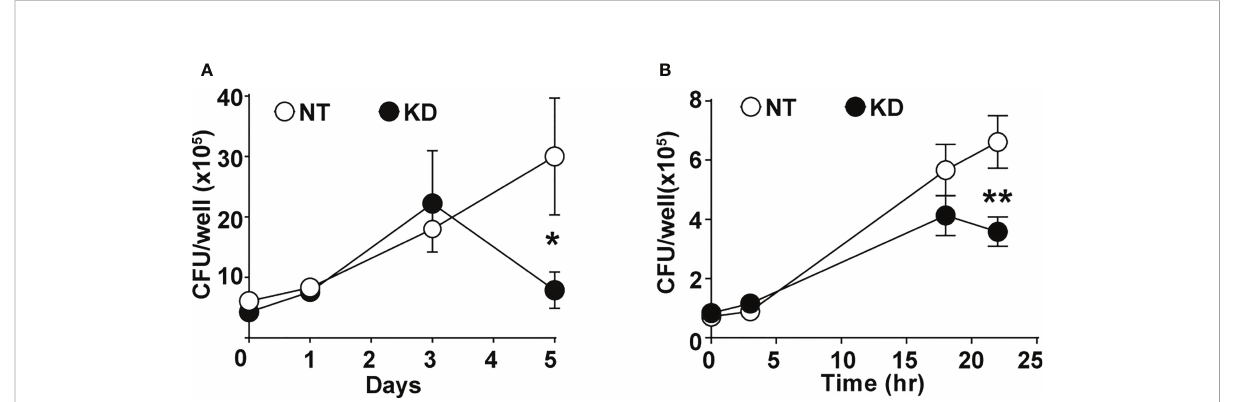
FIGURE 6 CMPK2 regulates the bactericidal activity of macrophages. (A) Growth kinetics of Mtb in NT and KD macrophages at different times post- infection at a MOI of 5 for 6 h Values are mean CFU ± SEM values in triplicate assays of N = 4. (B) Growth kinetics of STM in NT and KD macrophages at different times post-infection at a MOI of 10 for 20 min. Values are mean CFU ± SEM values in triplicate assays of N = 4. Mtb, Mycobacterium tuberculosis ; MOI, multiplicity of infection; CFU, colony-forming unit; STM, Salmonella enterica subsp. enterica serovar Typhimurium. *p<0.05,